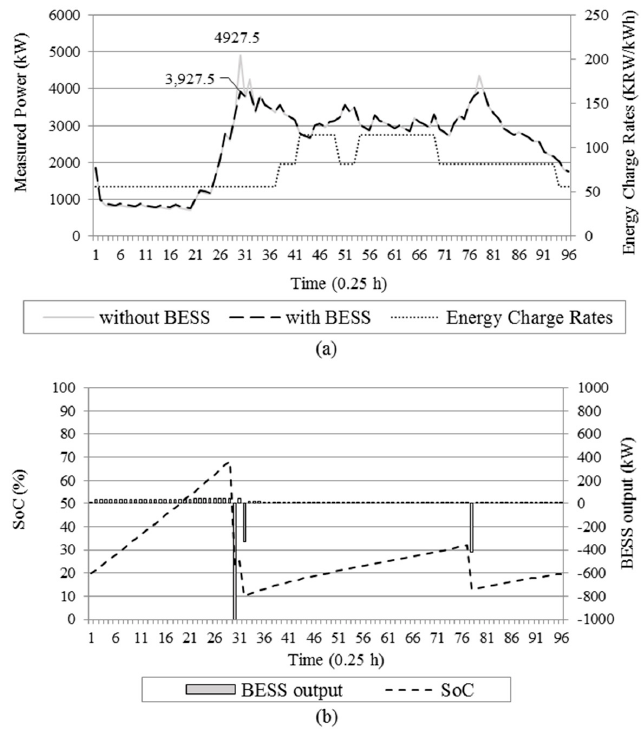
Figure 4. Result of Case 2 ( a ) Measured power, and ( b ) BESS output and SoC.